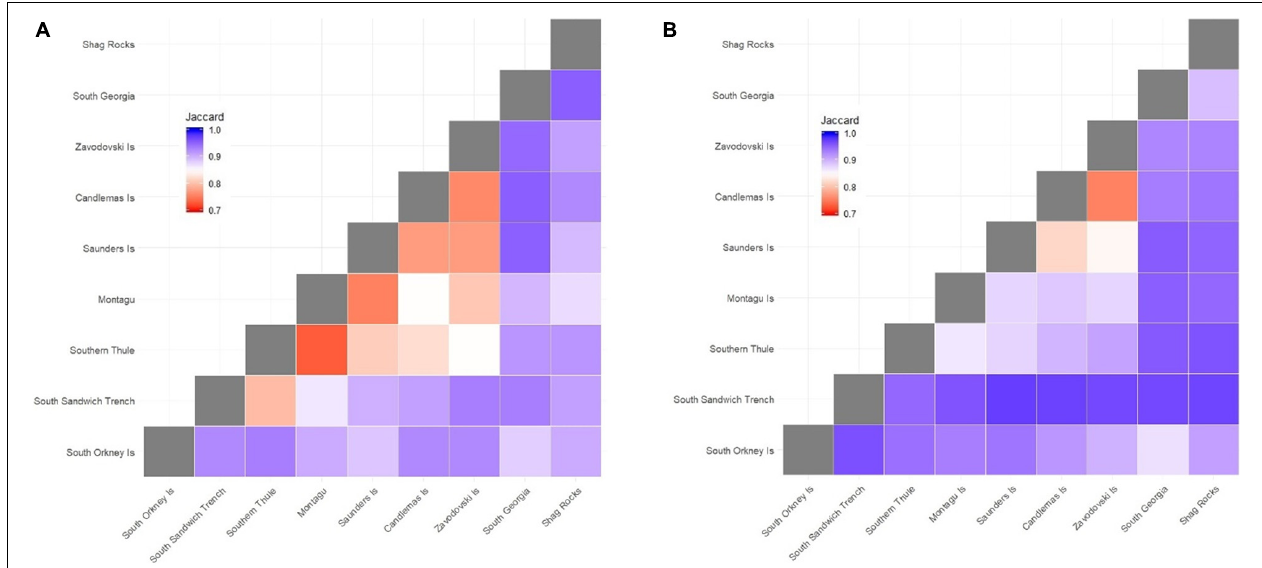
FIGURE 4 | Jaccard dissimilarity matrix of the benthic faunal composition of (A) families and (B) species across the Scotia Arc. Islands are ordered from south (South Orkney Islands) to north (Shag Rocks). Islands are delineated by 1,500 m depth contours. Zavodovski Island includes Protector shoal; Candlemas includes Visokoi Island and Southern Thule includes the Adventure and Kemp Caldera. Montagu Bank and Bristol Island were excluded from the analysis due to limited samples. The South Sandwich trench was delineated by the 4,000 m depth contour. South Georgia data were obtained from a biogeographic analysis by Hogg et al. (2011). South Orkney Islands data were sourced from GBIF (GBIF.org; accessed 11th April 2019).